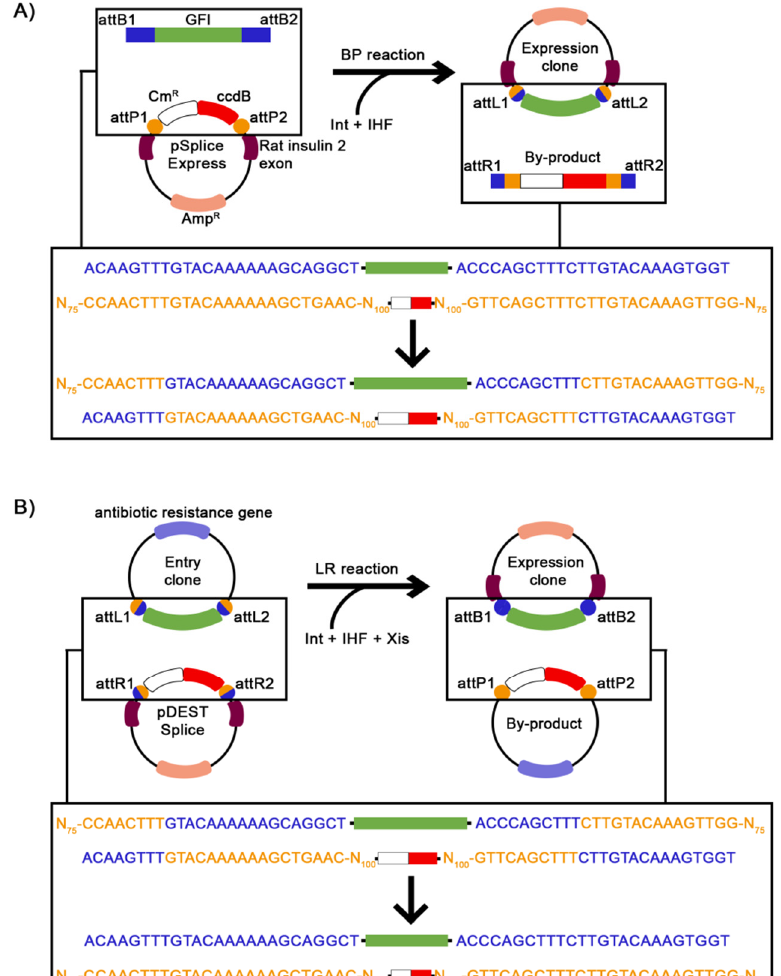
Figure 2. Gateway cloning with pSpliceExpress and pDESTsplice. ( A ) The BP reaction is mediated by Int and IHF and leads to the cloning of the GFI (green box) into pSpliceExpress. Initially, the GFI (green box), which contains one or more alternatively spliced exons together with flanking intronic sequences, is surrounded by 25 bps long attB1 and attB2 sites (dark blue boxes). Important sequences of the pSpliceExpress vector are those of the ccdB gene (red box), the chloramphenicol resistance gene (white box), the attP1 and attP2 sites (orange boxes), the Amp R gene (light pink box), and the rat insulin 2 exons 2 and 3 (burgundy boxes). The resulting Expression clone contains the sequences of the attL1 and attL2 sites (orange and dark blue circles) and the GFI. The ccdB gene and the chloramphenicol resistance gene segments flanked by attR1 and attR2 sites (dark blue and orange circles) form the by-product of the BP reaction. ( B ) The LR reaction is mediated by Int, IHF, and Xis and leads to the cloning of the GFI into the pDESTsplice vector. Important sequence parts of the Entry clone are the GFI flanked by the attL1 and attL2 sites and an antibiotic resistance gene (e.g., for kanamycin resistance, purple box). The pDESTsplice vector principally contains the same sequence elements as the pSpliceExpress vector, except that pDESTsplice contains the attR sites instead of the attP sites. The resulting Expression clone contains the GFI flanked by the attB sites. The by-product is a vector containing the ccdB gene sequence and the chloramphenicol resistance gene sequence flanked by the attP sites. The sequences of attB1/B2, attP1/P2, attL1/L2, and attR1/R2 represent the forward strand only and are displayed in the same colors as in the schemes above. Amp R : ampicillin resistance, att: attachment, Cm R : chloramphenicol resistance, GFI: genomic fragment of interest, IHF: integration host factor proteins, Int: integrase, Xis: